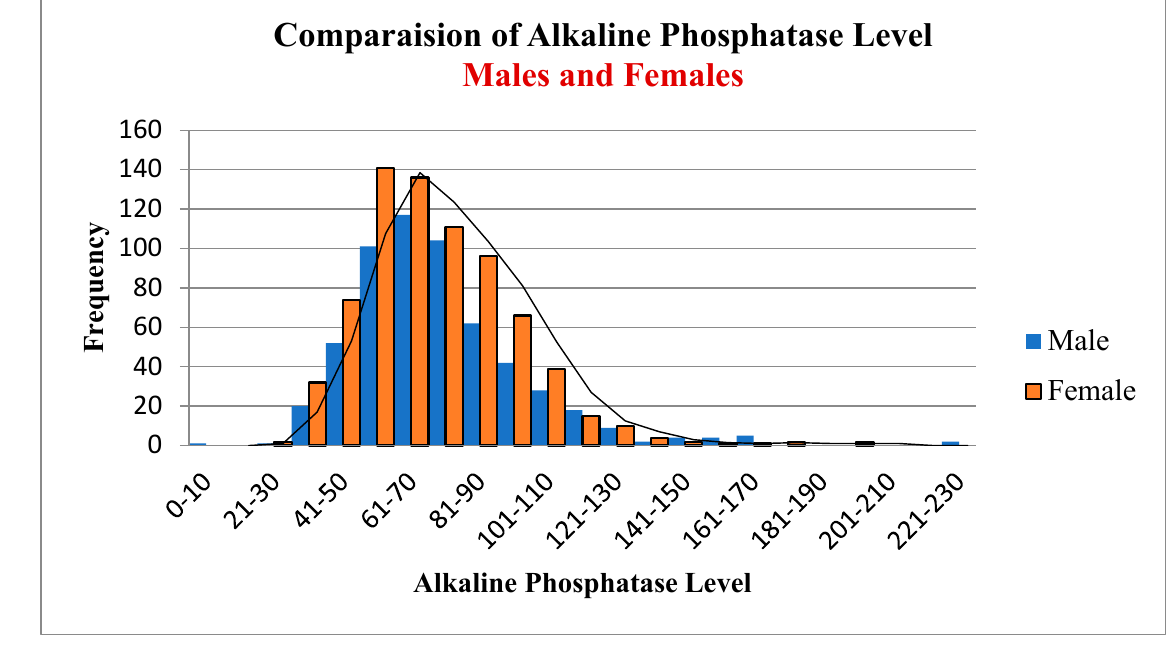
Figure 4. Alkaline phosphates in males and females.